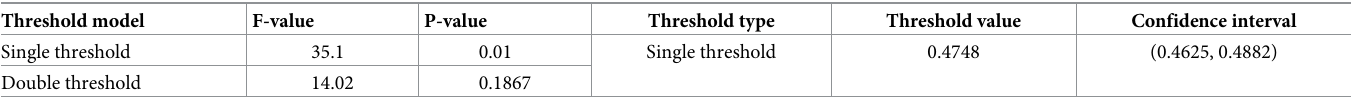
Table 3. Test result of threshold